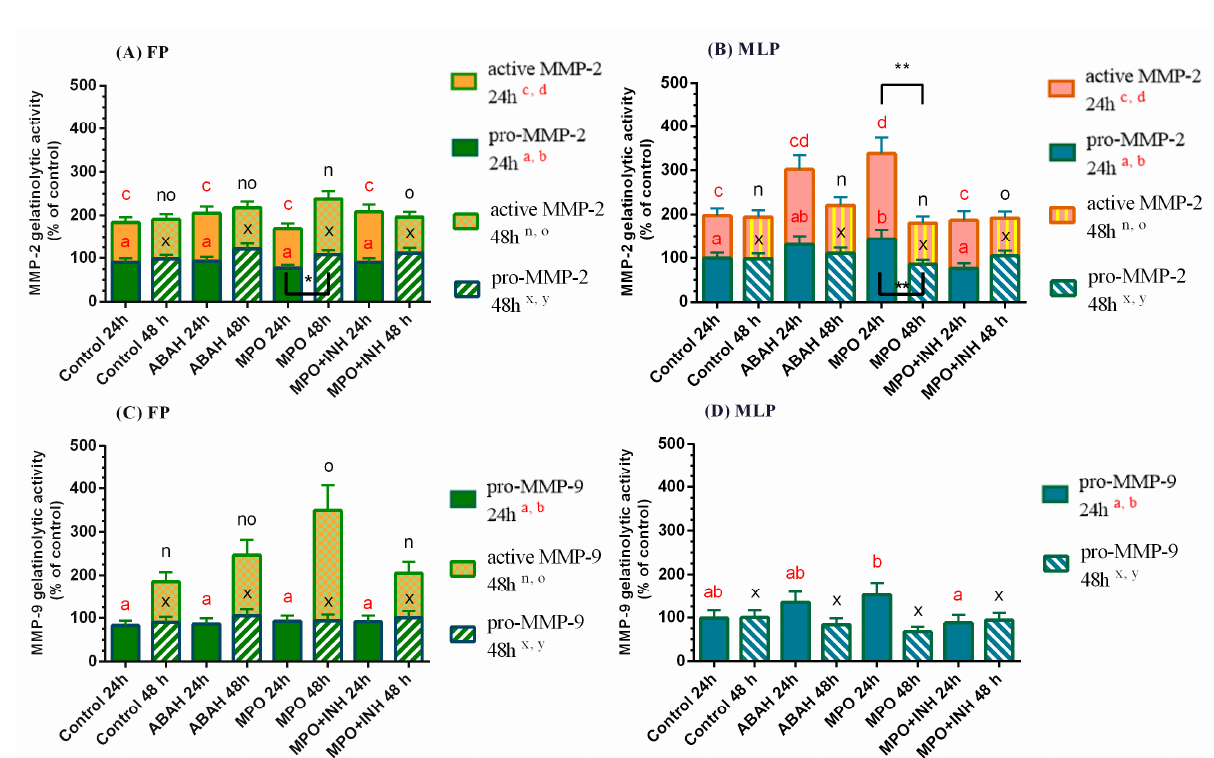
Figure 3. Relative MMP-2 ( A , B ) and MMP-9 ( C , D ) gelatinolytic activities in mare endometrial explants from the follicular phase (FP) and the mid-luteal phase (MLP) treated with culture medium only (Control), myeloperoxidase (MPO: 0.5 µ g/mL), 4-aminobenzoic hydrazide (ABAH: 10 µ g/mL), or MPO (0.5 µ g/mL) + ABAH (10 µ g/mL) for 24 or 48 h. Data of the least square means ± SEM are shown in bars as percentage of change from control. Significance was determined at p < 0.05. The differences among treatments with the same treatment time are signaled by distinct superscript letters. The differences among times of treatment for the identical treatment and MMP form are presented by asterisks (* p < 0.05; ** p < 0.01).